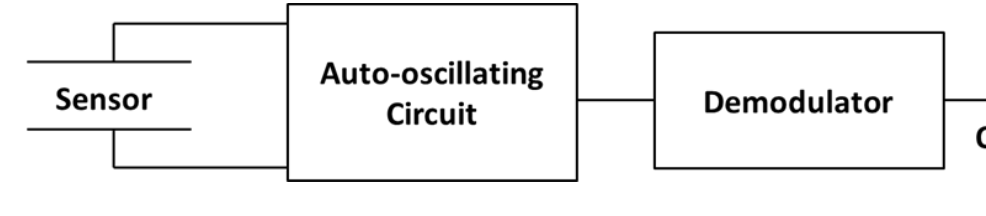
Figure 1. Block diagram of the device.